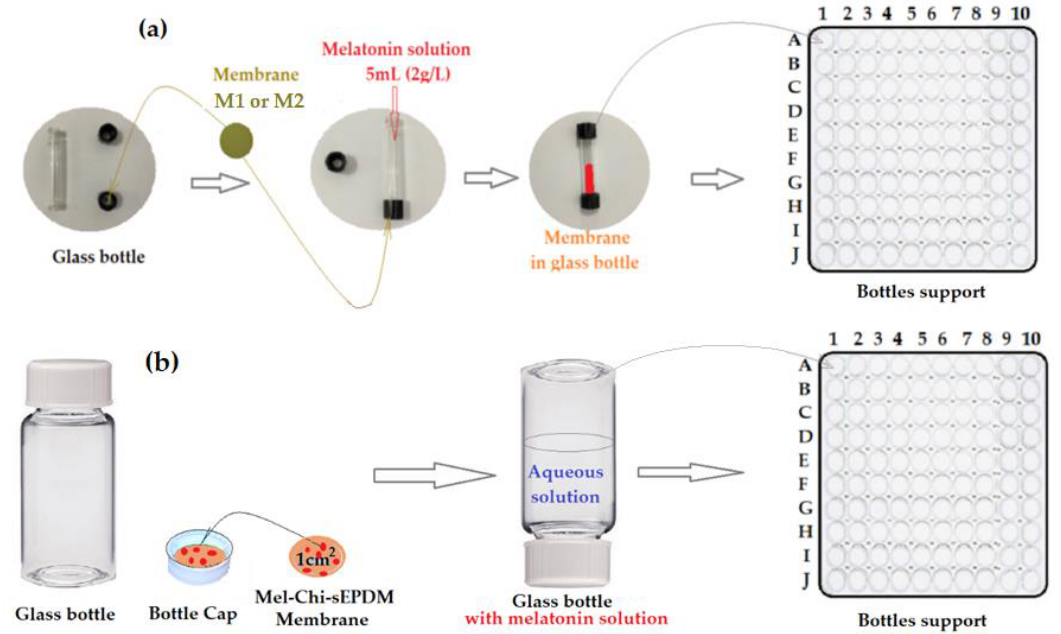
Figure 4. Release schematic procedure “through” prepared membranes (M1 and M2) ( a ); and release schematic procedure “from” composite membrane (M3) ( b ).